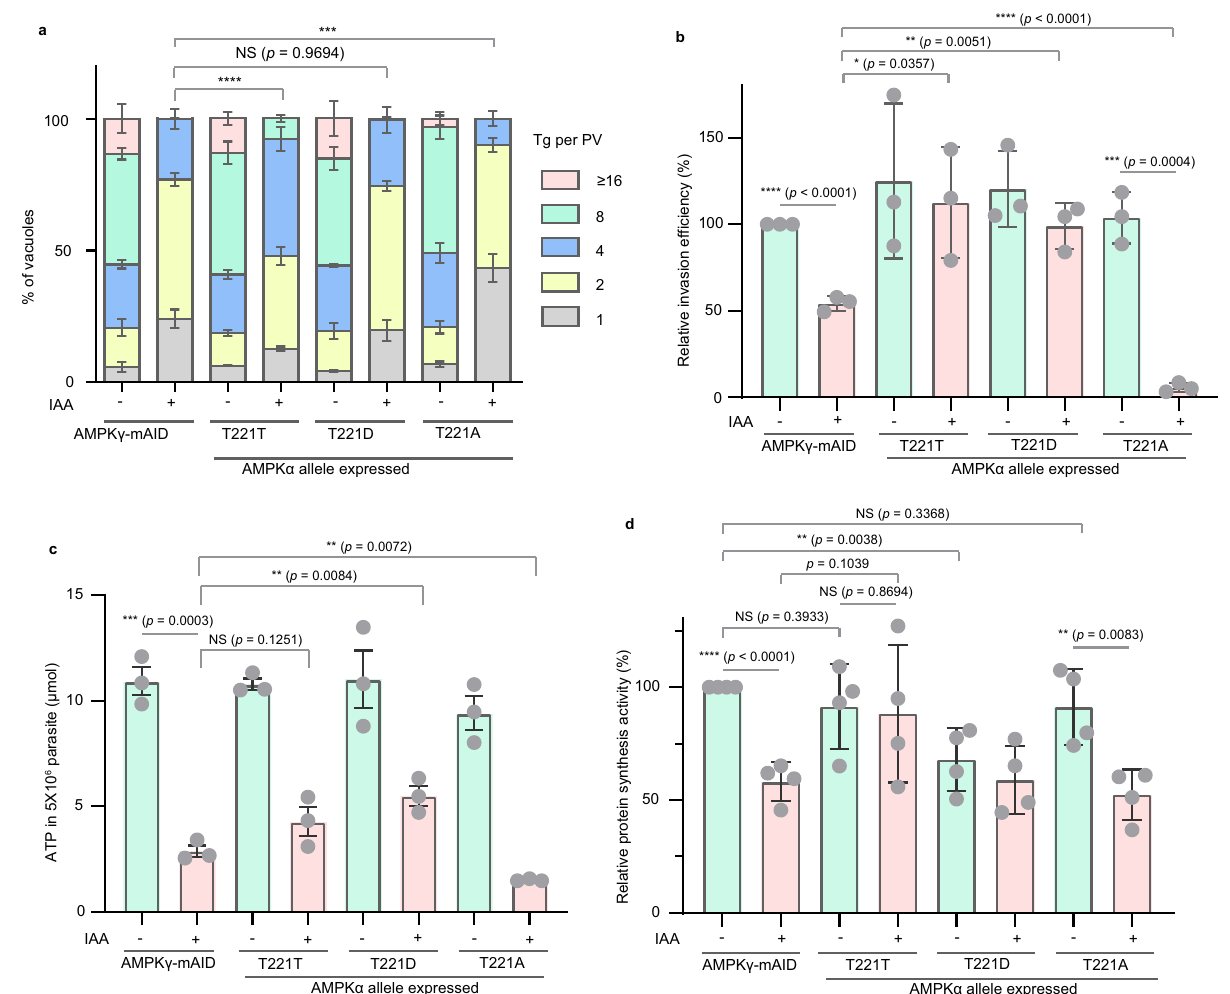
Fig. 5 | Effects of the expression of different alleles of TgAMPK α on the intra- cellular replication (a), invasion ef fi ciency (b), ATP level (c), and nascent pro- teinsynthesisactivity(d)ofTgAMPK γ depletedparasites. Allexperimentswere repeated n =3 ( a – c ) or n =4 ( d ) times independently and the Means±SEM are graphed. ***P =0.0004, ****P <0.0001, two-way ANOVA with Tukey ’ s multiple comparisons post-tests ( a ), unpaired two-tailed Student ’ s t -test ( b – d ). The